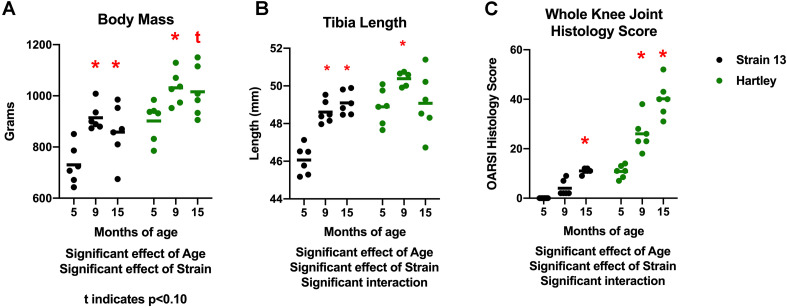
Differences in body mass, tibia length, and whole knee joint histology scores. There was a significant effect of age (p < 0.05) on body mass in both Strain 13 and Dunkin Hartley guinea pigs (A). Dunkin Hartley guinea pigs were significantly heavier than Strain 13 guinea pigs. 15 mo Dunkin Hartley guinea pigs tended to be larger than their 5 mo counterparts (p = 0.0560), while 15 mo Strain 13 guinea pigs were significantly (p < 0.05) larger than 5 mo Strain 13 guinea pigs. However, there was a significant age-related increase in tibia length in Strain 13 guinea pigs (p < 0.05) (B). There was a significant effect of age and strain (p < 0.05) on whole joint histology scores. Dunkin Hartley guinea pigs displayed a significant increase at 9 and 15 mo in OA severity while Strain 13 guinea pigs only displayed a significant increase at 15 mo (C). *denotes p < 0.05 compared to 5 mo. *denotes p < 0.05 compared to 5 mo of the same strain; t denotes p < 0.10 compared to 5 mo of the same strain.